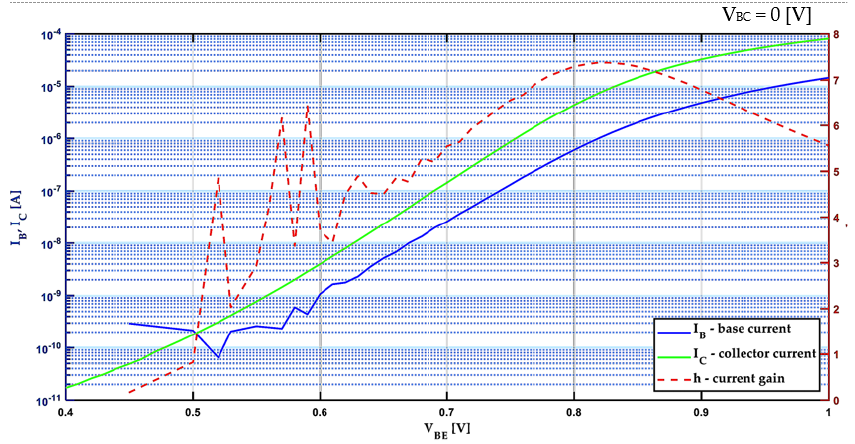
Figure 9. Example of the characteristics of the p-n-p device, current gain factor = 7.38.